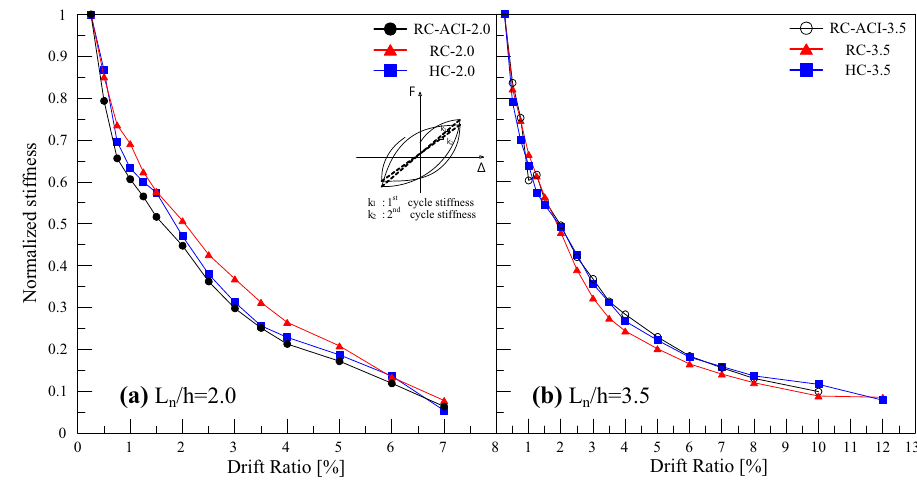
Fig. 12 Stiffness normalized by initial stiffness.